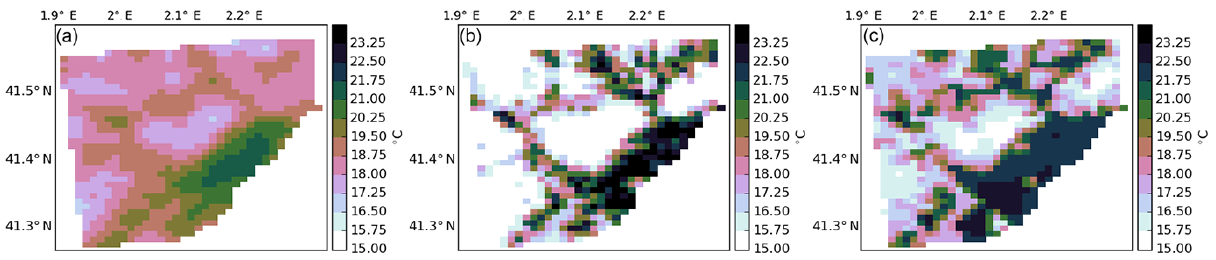
Figure 8. Land surface temperature averaged during nighttime hours over the period May–September 2011 in MODIS (left), UC-ERA (cen- tre) and WRF